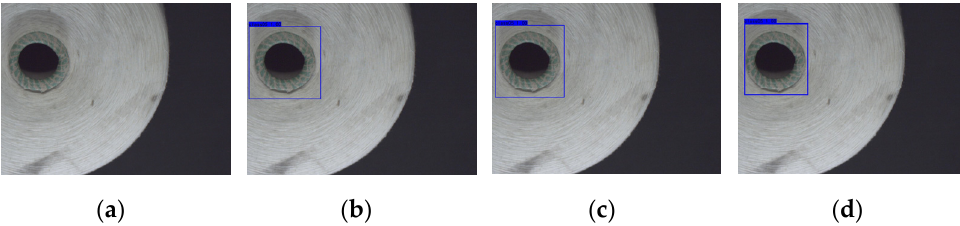
Figure 16. Identification of cone yarn with worn bobbin: ( a ) original image; ( b ) YOLOv3 + DarkNet- 53 algorithm recognition results; ( c ) Faster R-CNN + VGG16 algorithm recognition results; ( d ) Faster R-CNN + ResNet50 algorithm recognition results.